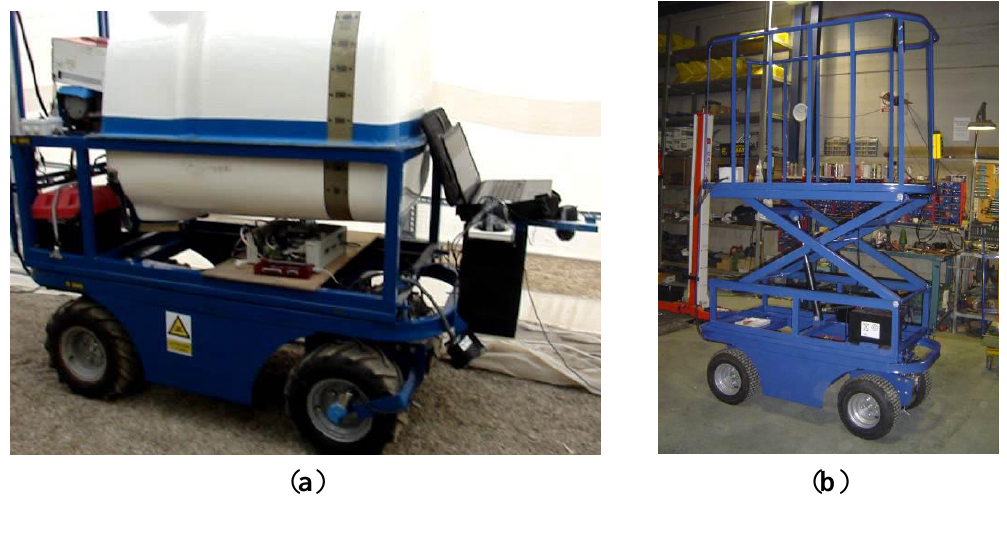
Figure 4. ( a ) Vehicle equipped with the spraying system (phytosanitary tank). ( b ) Vehicle equipped with the lifting platform